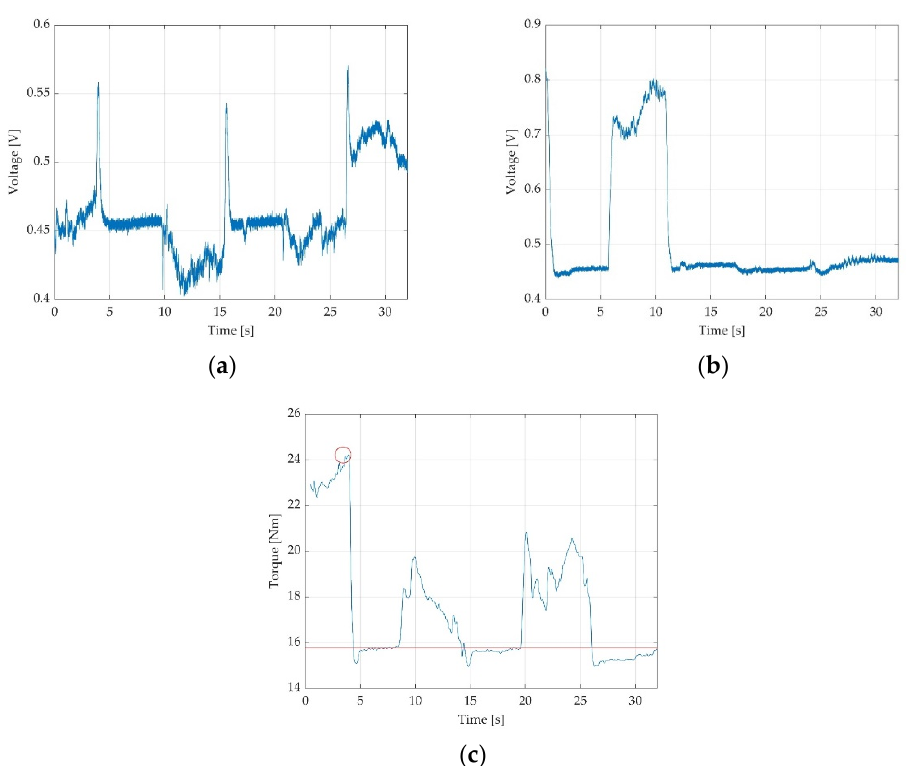
Figure 6. Examples of improper acquisition due to: ( a ) participant error; ( b ) testator command error; ( c ) an invalid time graph due to participants’ improper discipline/behaviour, mainly induced by pain during testation.